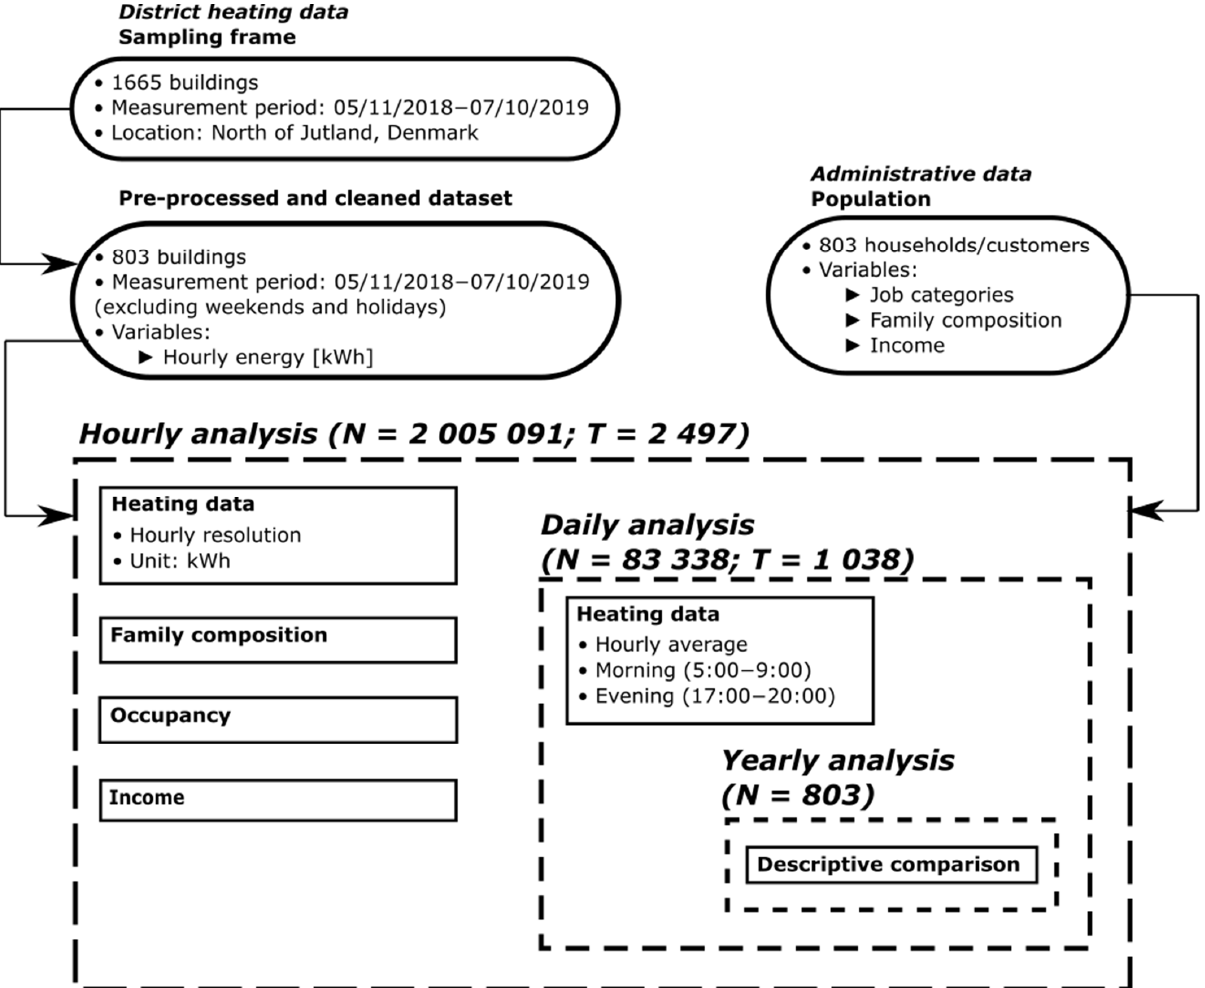
Figure 2. Overview of data structure and the applied analysis process.